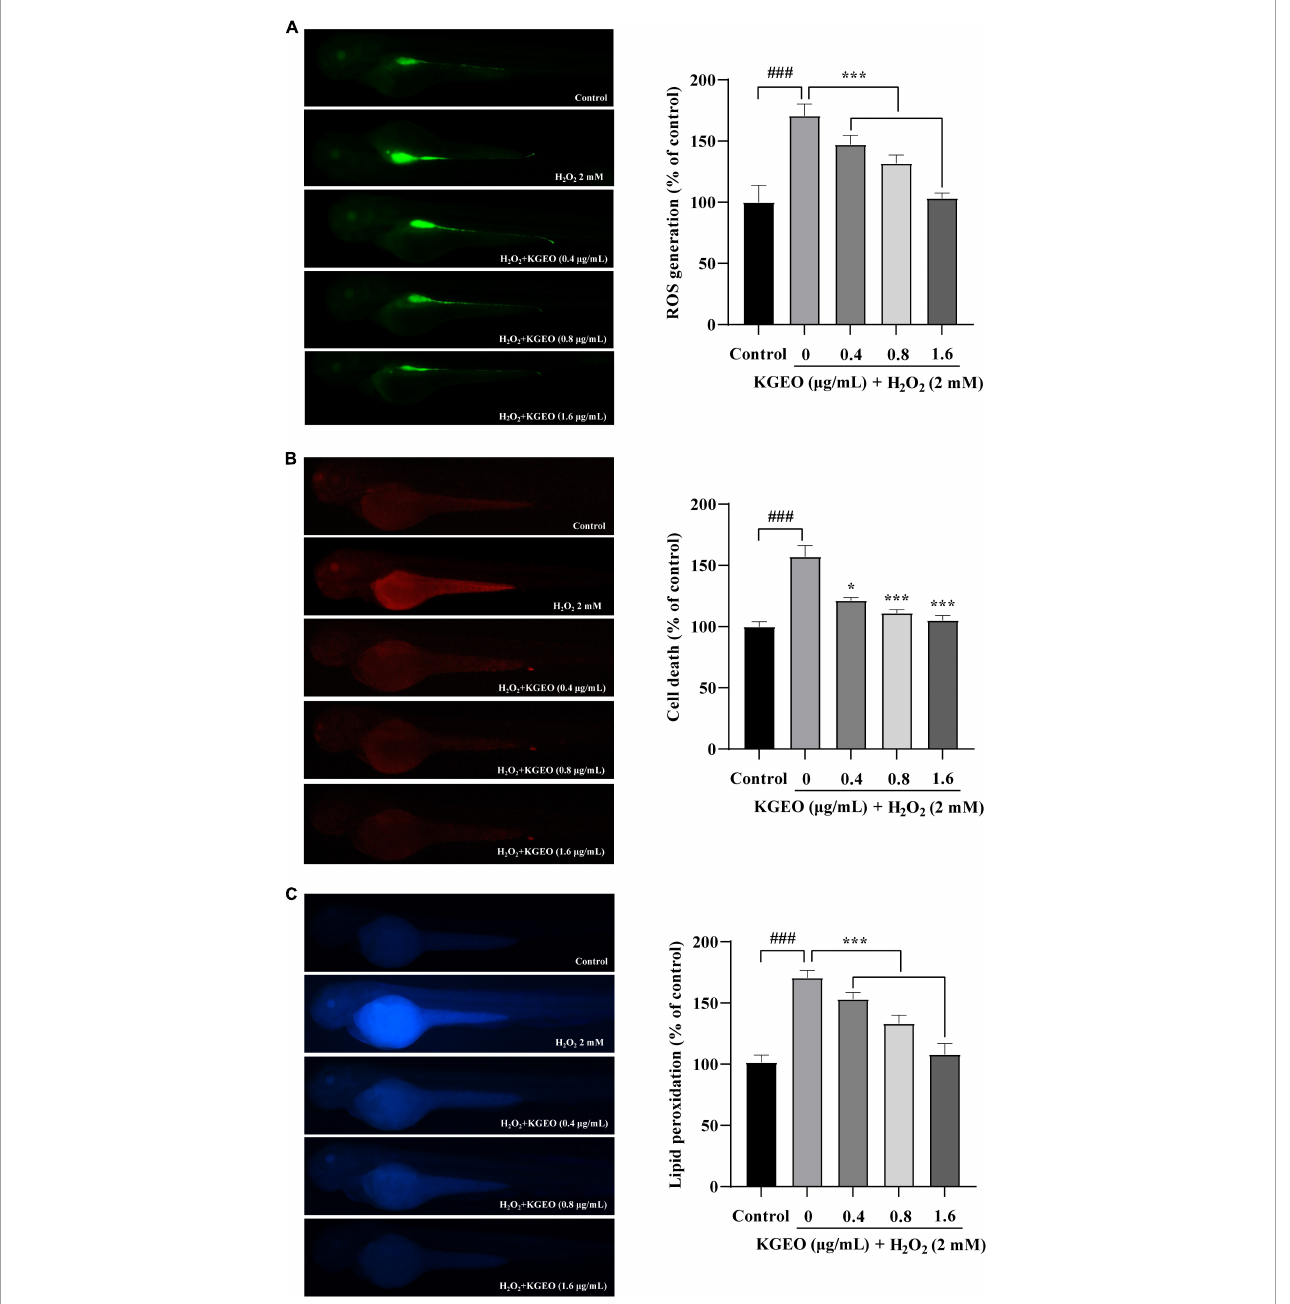
FIGURE2 The effects of Kaempferia galanga essential oil (KGEO) on H 2 O 2 -induced ROS Production, cell death, and lipid peroxidation in zebrafish. The protective effect of KGEO against H 2 O 2 -induced ROS generation (A) , Cell death (B) , and lipid peroxidation (C) . The relative fluorescence intensities of zebrafish were analyzed using ImageJ software. The data were expressed as the mean ± SD ( n = 15). ### P < 0.001 as compared to the control group. * P < 0.05, *** P < 0.001 as compared to the H 2 O 2 -treated